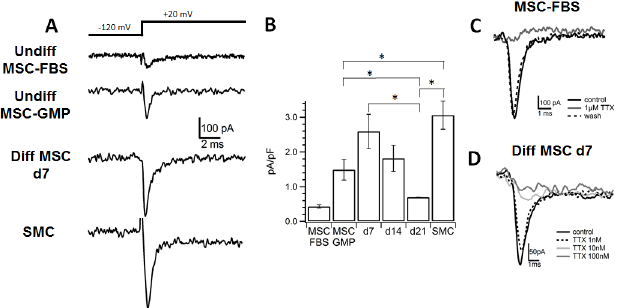
Fig 6. Levels of voltage-activated Na + currents and Na + channels. (A) Voltage-activated Na + currents were elicited by a voltage step from -120 mV to +20 mV. MSCs: trace from undifferentiated MSCs in control medium (undiff MSC-FBS) and GMP expansion medium (MSC-GMP); d7: trace from MSCs after 7 days in myogenic differentiation medium; SMC: trace from primary bladder SMCs. Capacitive transient is blanked for better visualization. (B) Na + current density for undifferentiated MSCs in control medium (MSC FBS) and GMP medium (MSC GMP), as well as MSCs differentiated for 7, 14 or 21 days and SMCs, respectively. n = 10 – 20. * p < 0.05. Error bars indicate SEM. (C) Effect of TTX on Na + currents in undifferentiated MSCs (here: MSC in control medium). Superposition of Na + currents elicited at +20mV. Na + channels could be blocked by the specific Na + channel inhibitor TTX. (D) Effect of TTX on Na + currents in MSCs that were differentiated for 7 days. Superposition of Na + currents elicited at +20mV. TTX blocks the current concentration-dependently.